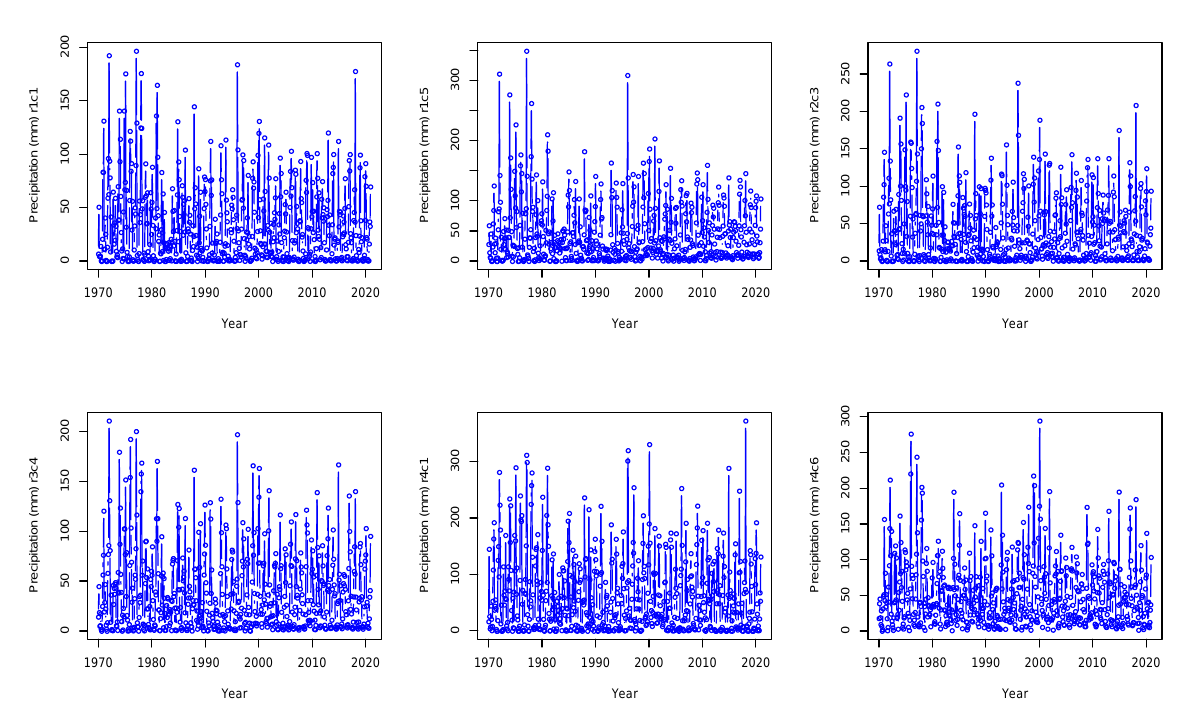
Figure 6. Plots of precipitation for the grids: r1c1, r1c5, r2c3, r3c4, r4c1 and